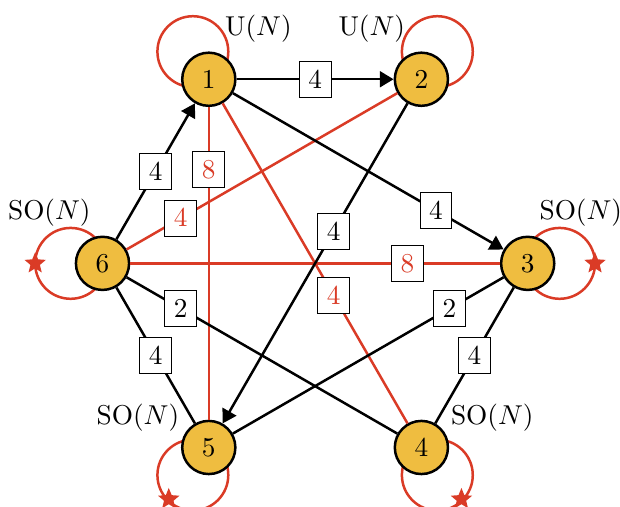
Figure 30 . Quiver diagram for the Spin(7) orientifold of phase J of Q 1 , 1 , 1 / Z 2 using the involution in eqs. (C.14), (C.15) and (C.16), together with our choice of γ